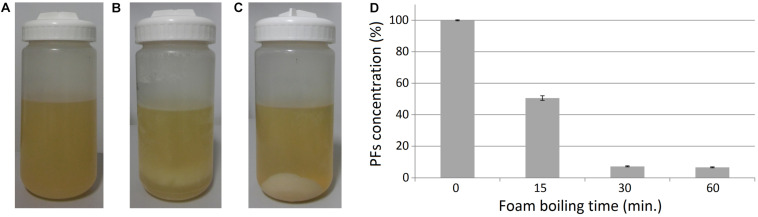
Effect of heating on the clarified foam supernatants. (A) Clarified foam supernatant (SUP) obtained after foam centrifugation and removal of cell pellets. (B) Sample boiling resulted in a formation of pellets in the samples, (C) which can be separated with centrifugation. (D) Relative amounts of PFs in supernatants after boiling. The initial concentration of PFs in the unboiled samples (0 min) was 607.7 ± 2.0 mg/L (100%).